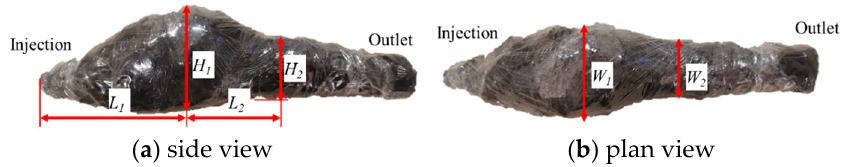
Figure 13. Shape and dimension of cavity (expanding foam). Table 2. Dimension variation of cavity caused by different oxygen proportions (injection flow rate 2.4